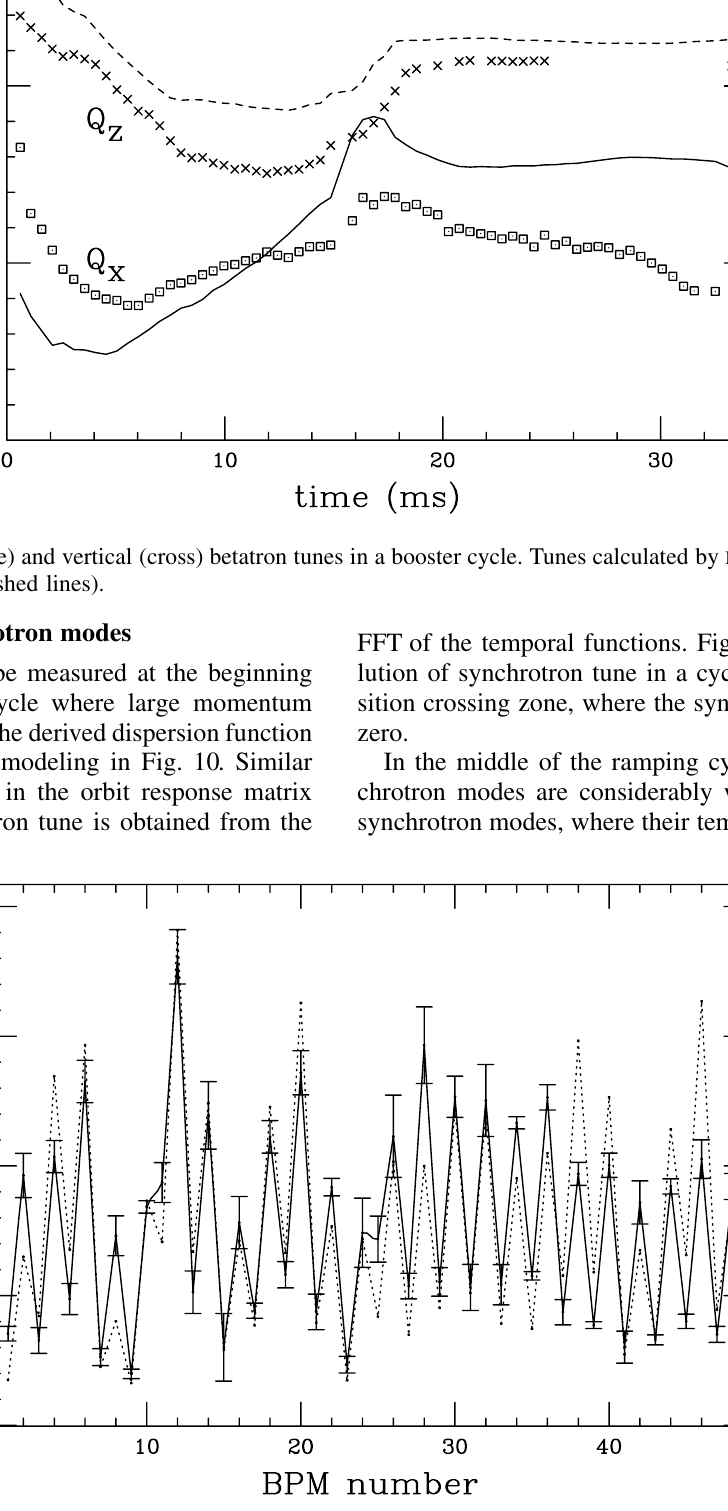
FIG. 10. The measured dispersion function is compared with the MAD modeling (dotted line) based on a realistic Fermilab Booster lattice. The error bars were estimated with the standard deviation of the dispersion function derived from the four data sets.